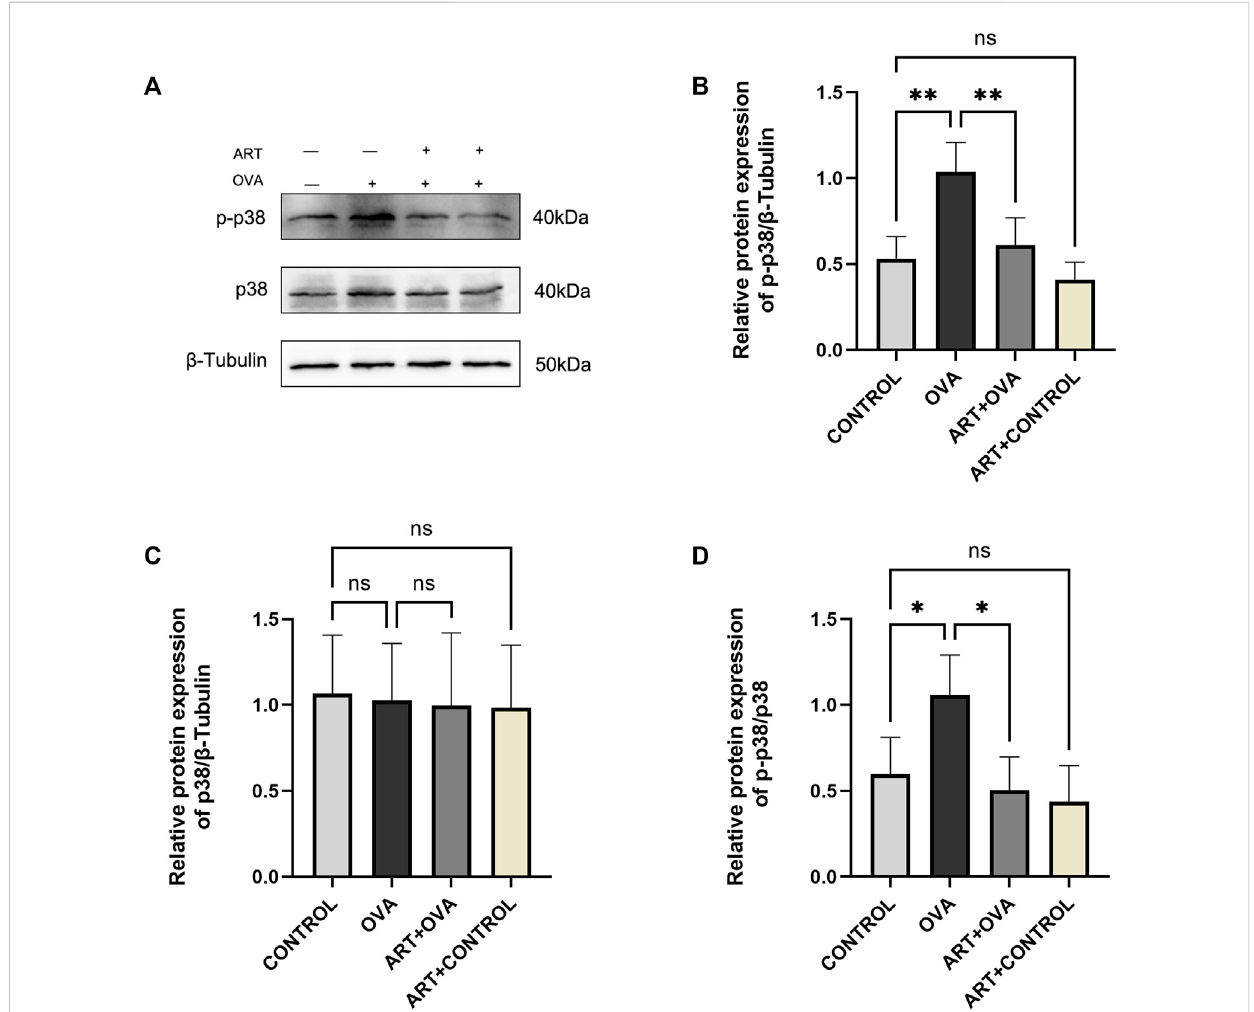
FIGURE 9 ART attenuated OVA-induced asthma by inhibiting p38 phosphorylation. (A) The expression of total p38 and phospho-p38 proteins in each group lungs ( n = 4). (B – D) Quantitative analysis of protein levels in each group ( n = 4). * p < 0.05, ** p < 0.01.